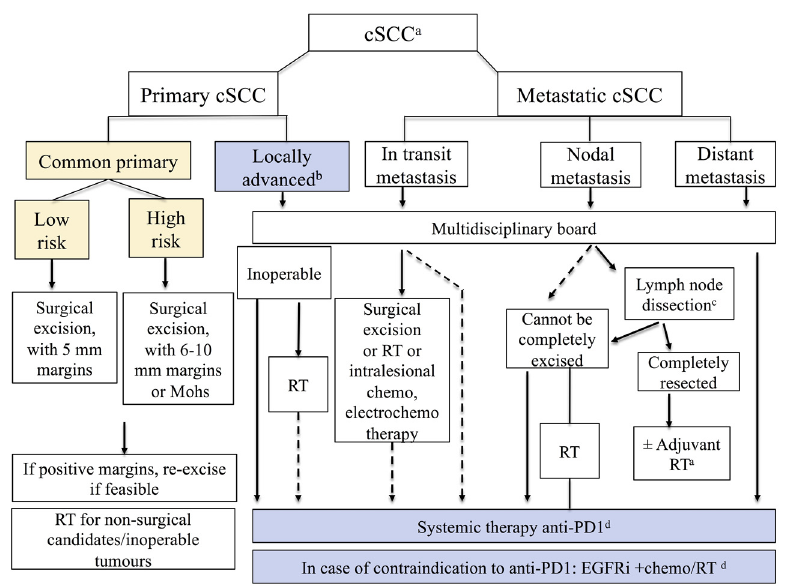
Figure 1. Classification of invasive cSCC in common primary cSCC (high-risk or low-risk) and ad- vanced cSCC, according to the European guidelines (reproduced with permission from [2]; published by the European Journal of Cancer, 2020). In addition, it is noted that since the publication of this figure, anti-PD-1 agent pembrolizumab has been approved by US FDA for patients with recurrent or metastatic cSCC that is not curable by surgery or radiation. EGFRi: EGFR inhibitors, RT: radiotherapy; a For detailed indications and recommendations of treatment, refer to relevant section text in the European guidelines; b Locally advanced, by definition not amenable to curative surgery or curative RT; c Lymph node dissection as indicated; d All systemic treatments are off-label, except for anti-PD-1 agent cemiplimab that is approved by FDA/EMA for patients with locally advanced or metastatic cSCC who are not candidates for curative surgery or curative radiation.